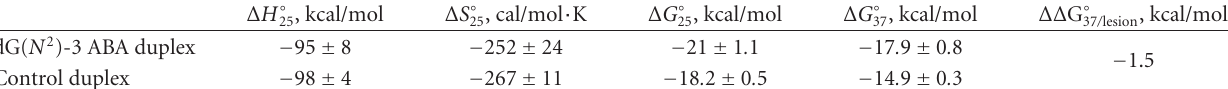
Table 1: Thermodynamic parameters of ABA-modified and unmodified tetradecamer duplexes.